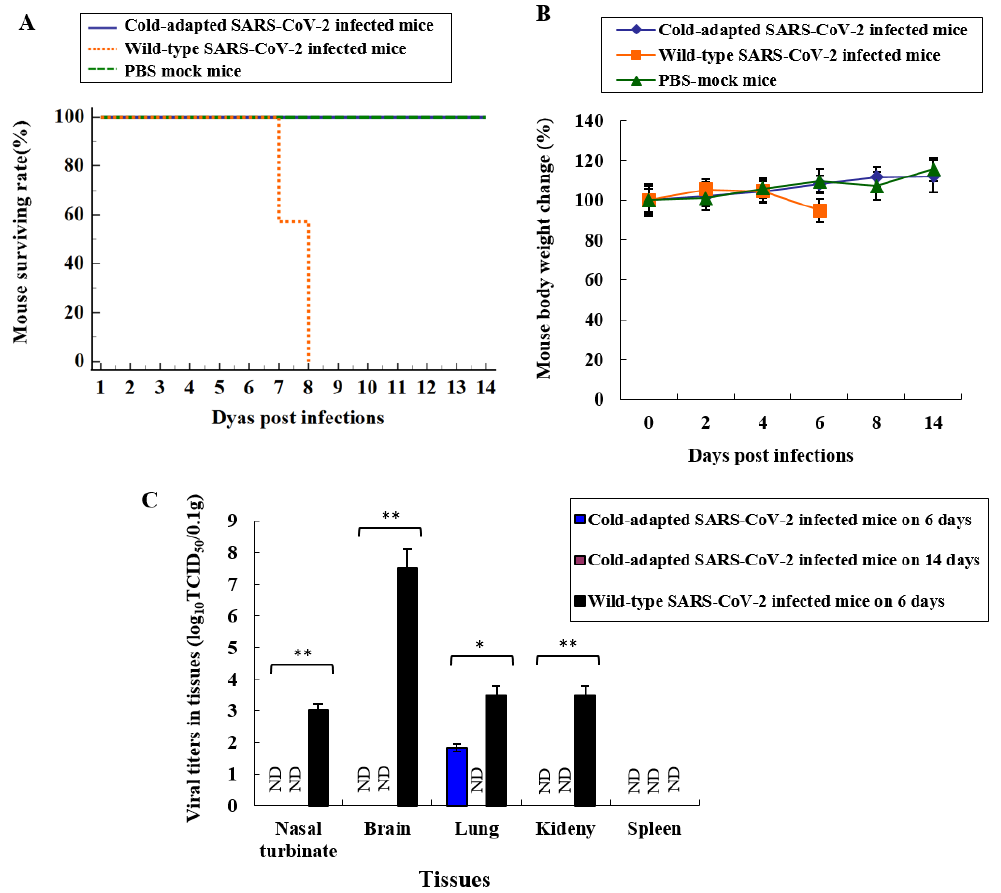
Figure 1. Attenuation of cold-adapted SARS-CoV-2 vaccine strain in hACE2 transgenic mice. K18-ACE2 mice were i.n. infected with cold adapted SARS-CoV-2 (CoV-2-CNUHV03-CA22 ◦ C (2 × 10 4 pfu) ( n = 14) or were i.n. infected with wild-type SARS-CoV-2 (CoV-2-CNUHV03) (2 × 10 4 pfu) ( n = 10). Mice were monitored for mortality and the change of body weights for 14 days. On day 6 p.i., mice ( n = 3 per group) were euthanized for viral titers in tissues. On day 14 p.i., mice ( n = 3) infected with CoV-2-CNUHV03-CA22 ◦ C were also euthanized. PBS-mock infected K18-ACE-2 mice ( n = 4) were used as a control group and among them, one mice were euthanized on day 6. ( A ) Mice mortality rate (%); ( B ) the change of mouse body weights (%) compared to those before infections, ( C ) viral titers in mouse tissues ( n = 3 per group) of nasal turbinate, brain, lung, kidney, and spleen by log 10 TCID 50 / 0.1 g. Viral titers are the mean of 3 tissues ± standard deviations. Detection limit of virus is 1 TCID 50 / 0.1 g. * p < 0.05, ** p < 0.001, ND: non-detected We measured the virus titres in different tissues (nasal turbinates, brain, lungs, kidneys, spleen) of infected mice by determining the log10 tissue culture infectious dose 50 (log10TCID50) values in Vero cells as well as by performing real-time quantitative polymerase chain reaction (RT-qPCR) with SARS-CoV-2 N primers and probe on day 6 p.i. The virus titres were lower in the tissues of K18- hACE2 mice infected with CoV-2-CNUHV03-CA22 °C compared to the tissues of K18-hACE2 mice infected with CoV-2-CNUHV03 (Figure 1C, and Figure S2). When we measured the virus titres in terms of the log10TCID50 value, viruses were detected only in the lungs of K18-hACE2 mice infected with CoV-2-CNUHV03-CA22 °C with a titre of 1.83 TCID50/0.1g; however, the virus was detected in the nasal turbinates (3.0 TCID50/0. g), brain (7.5 TCID50/0.1 g), lungs (3.5 TCID50/0.1 g), and kidneys